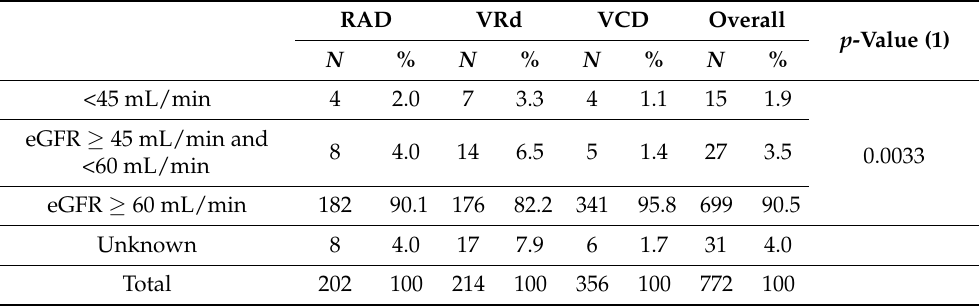
Table 5. Renal recovery—estimated glomerular filtration rate after induction therapy in the categories (used by KDIGO 2012). Population: per-protocol set, N =